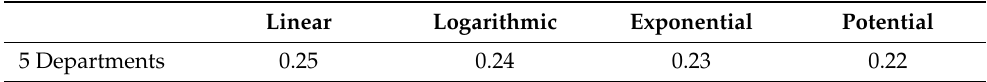
Table 5. R 2 value when correlating departmental GDP and average travel speed between villages and districts with their municipal